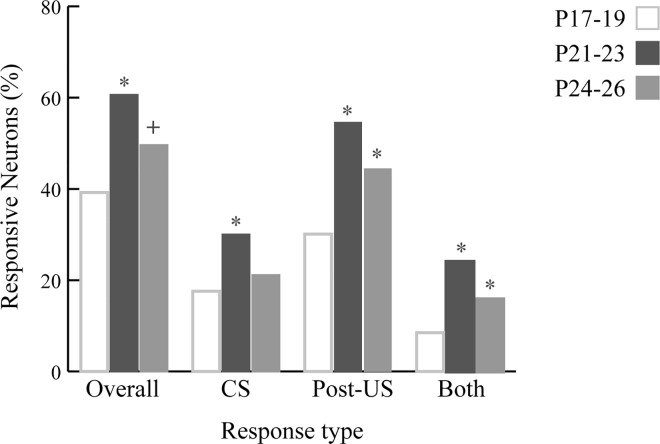
The distribution of response types of CA1 pyramidal cells in rat pups.The response types were categorized as Overall, CS, Post-US, and Both responsive. The P21-23 group showed the highest proportion of responsive neurons in all conditions. The oldest age group had more responsive neurons than the youngest in the Overall, Post-US, and Both conditions. The neurons in the youngest group were less responsive to the post-US period, compared to the older age groups. Asterisks represent the statistical significance of alpha < 0.05. Green cross indicates alpha = 0.05.